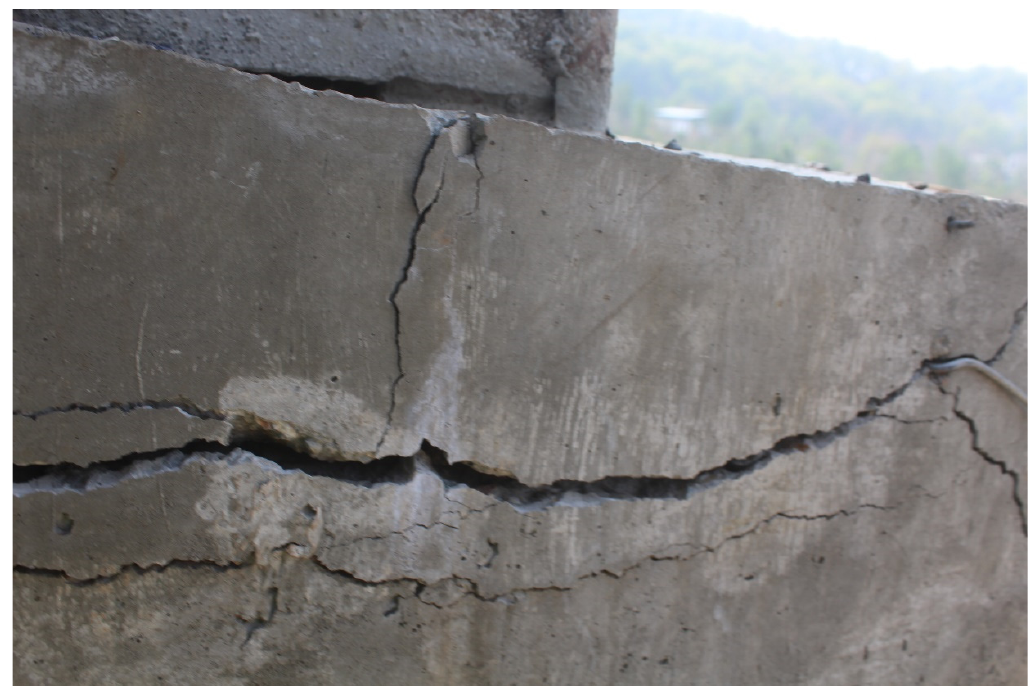
Figure 25. End of Span-4 over Abutment-2. Some temporary suspension cables were anchored at abutment and others were anchored near the end of Span-4 deck.